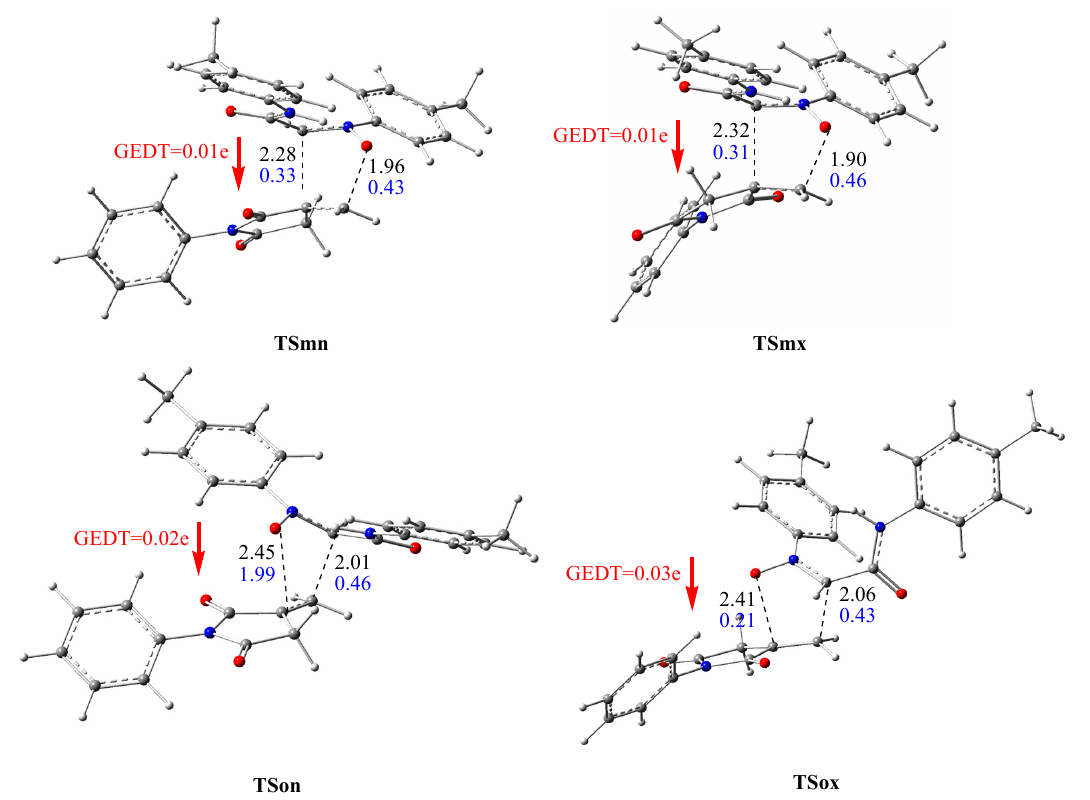
The optimized structures of the transition states associated with the 32CA reaction of nitrone 2 with ethylene 1 together with the lengths of the new bonds and their Wiberg bond indices are given in Figure 3.